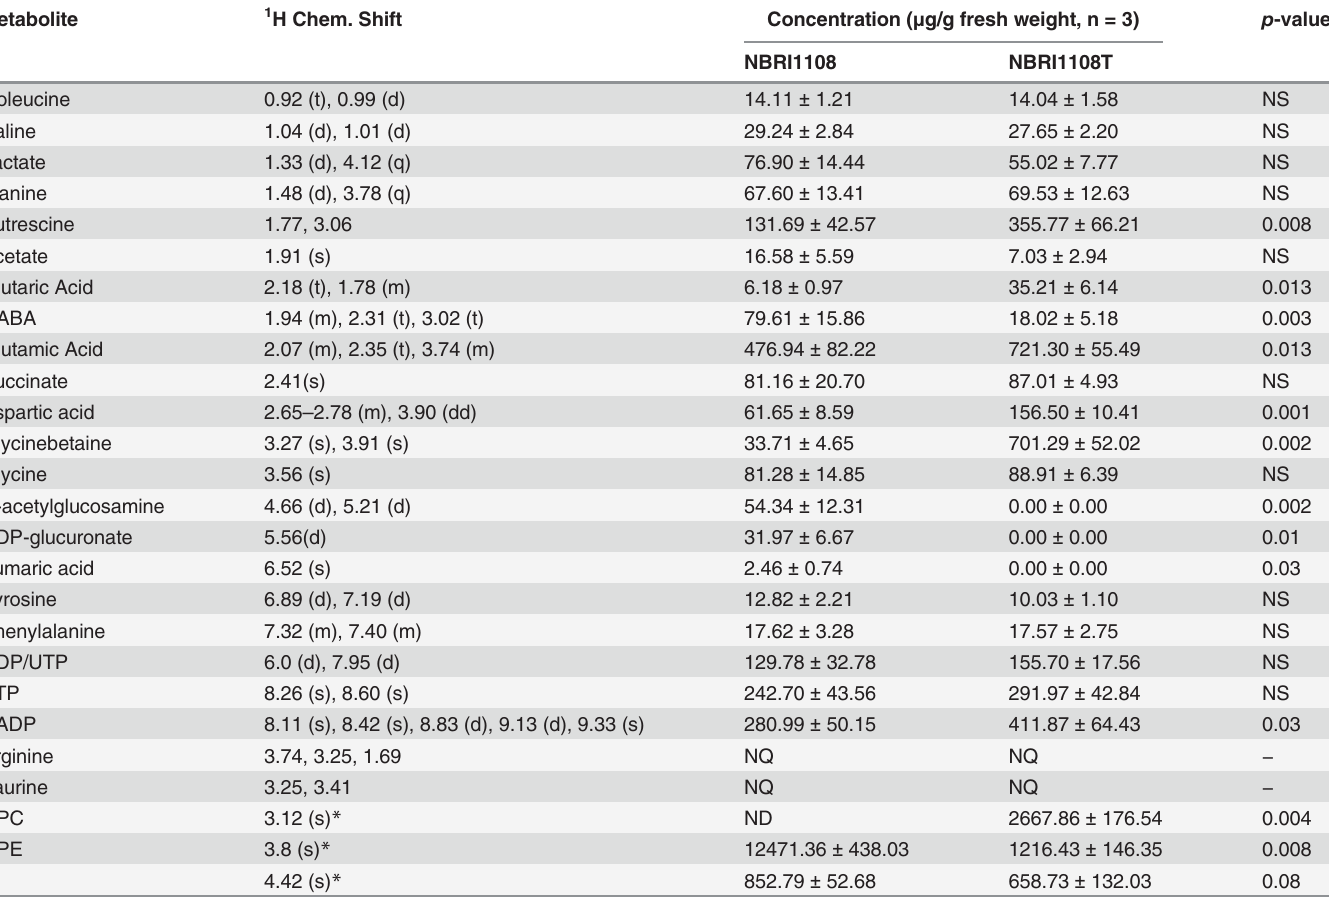
Table 1. Variability in 1 H and 31 P NMR identi fi ed metabolites of P. putida NBRI1108 and NBRI1108T.